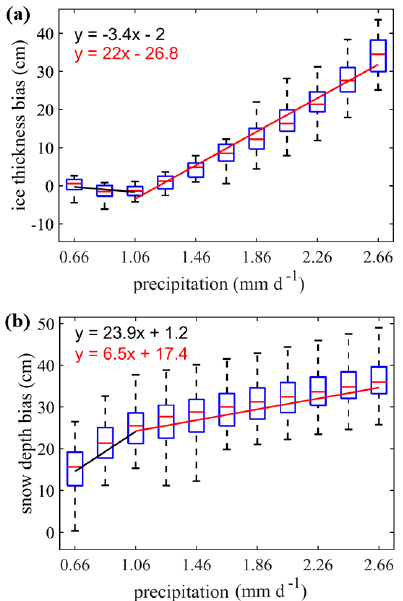
Figure 6. Box plot of simulation bias (simulation minus observa- tion) of (a) sea ice thickness and (b) snow depth over the daily mean precipitation in the different sensitivity experiments ( n in- creases from left to right). On the x axis, 0.66mm refers to the experiment with n = 0 (in situ precipitation), and 2.66mm refers to the n = 10 experiment (ERA5 precipitation). Two linear regression lines (black and red) are derived for x ≤ 1 . 06mm and x > 1 . 06mm based on the mean of ice thickness and snow